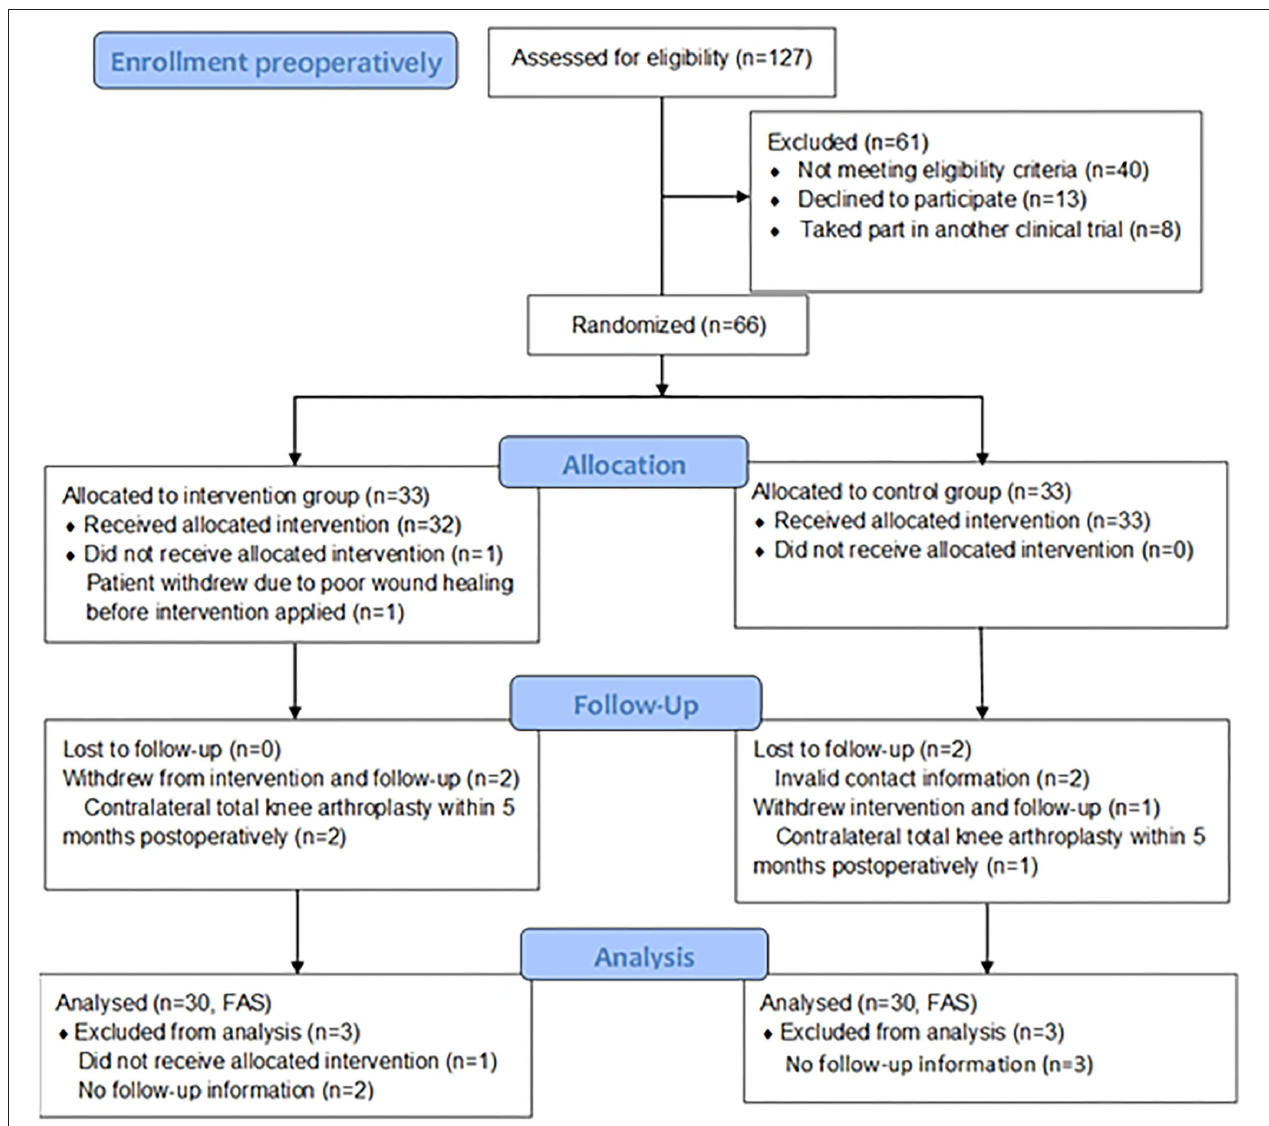
FIGURE 1 | Flow diagram of the participants through the study [With reference to the CONSORT 2010 Flow Diagram, Schulz KF, et al., BMJ, 2010, 340: p. c332;